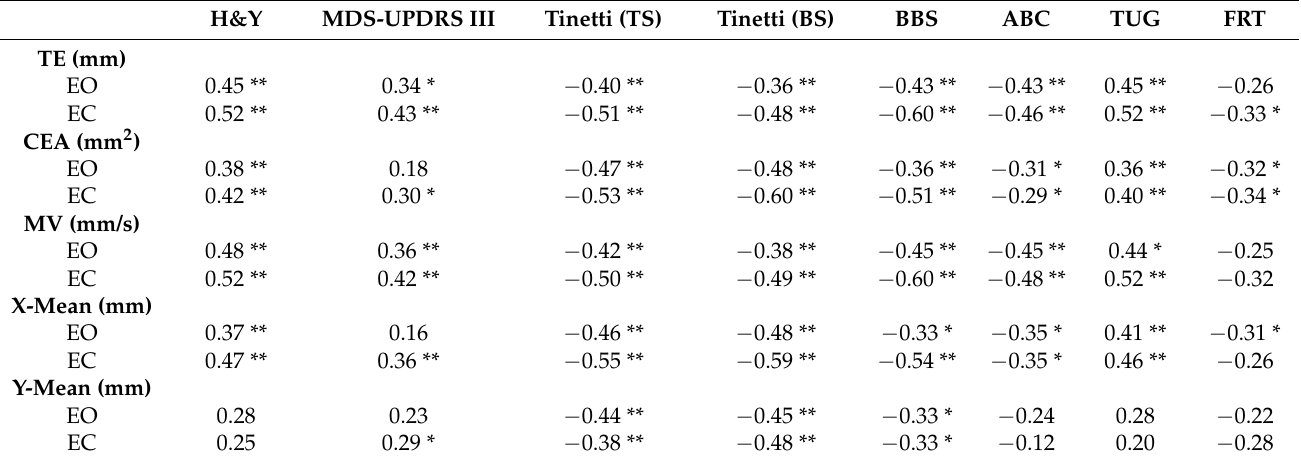
Table 4. Correlation coefficient ( r or ρ ) between clinical balance tests and posturographic